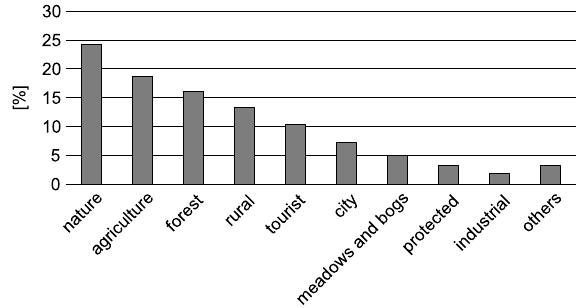
respondents.Fig. 4. Landscape types which respondents associate with lubelskie